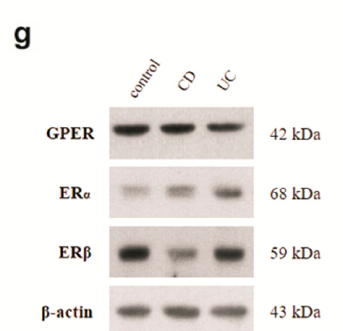
Figure 6. Expression of GPER ( a , b ), ER α ( c , d ) and ER β ( e , f ) at the mRNA ( a , c , e ) and protein level ( b , d , f ) in females with CD and UC over the age of 50 years and related controls (control, n = 10; CD, n = 5; UC, n = 6). Representative immunoblots of GPER, ER α and ER β ( g ). Values are means ± SEM; * P < 0.05, ** P < 0.01 vs. control.